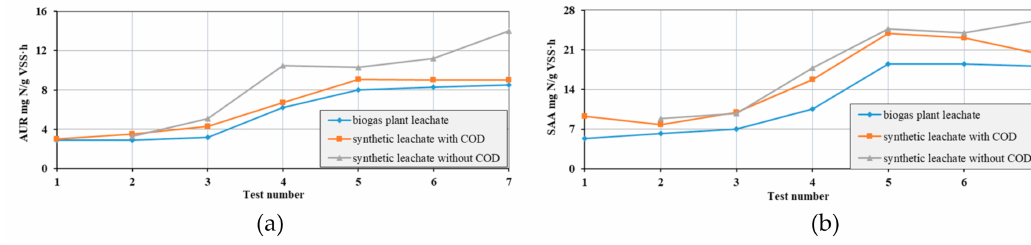
Figure 2. Values of ( a ) AUR ( b ) SAA for anammox process carried out with LPD addition, with synthetic e ffl uents with COD and with synthetic e ffl uents without